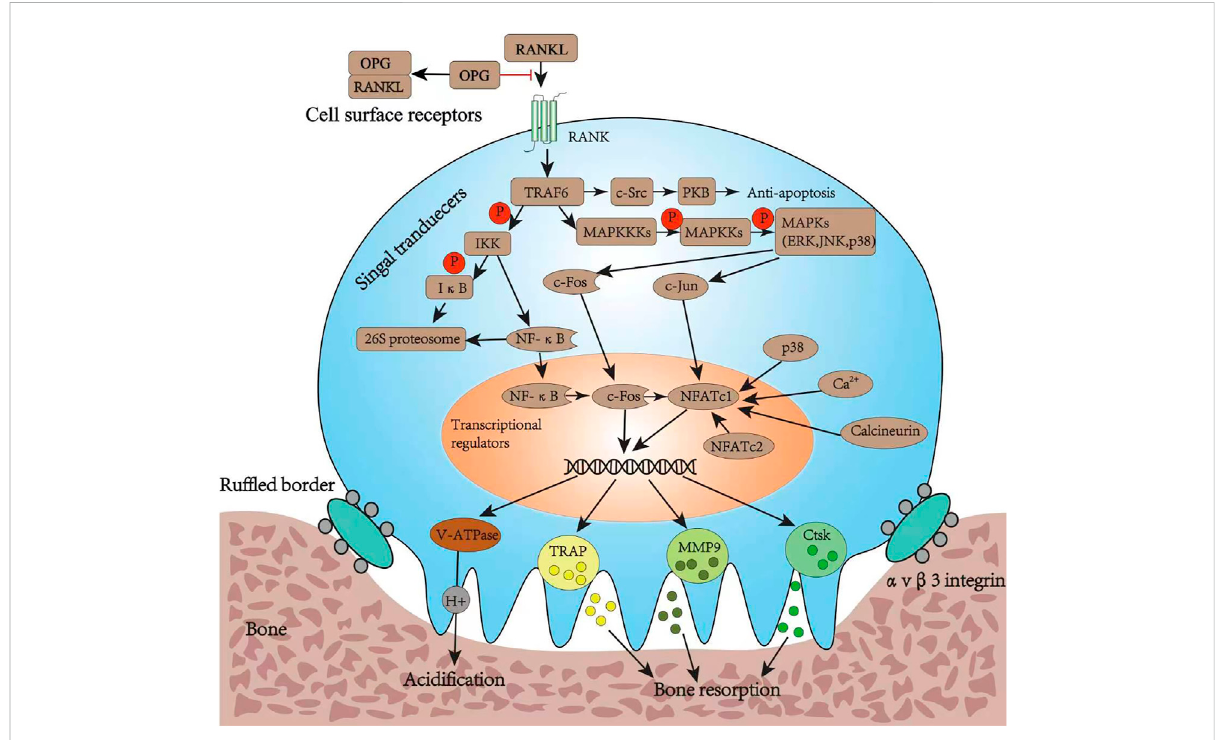
FIGURE 3 Osteoclast differentiation pathways and its bone resorption function. RANKL, ligand of receptor activator of nuclear factor κ B; RANK, receptor activator of nuclear factor κ B; OPG, osteoprotegerin; TRAF6, tumor necrosis factor receptor-associated factor 6; IKK, inhibitor of nuclear factor κ B kinase; I κ B, inhibitor of nuclear factor kappa B; NF- κ B, nuclear factor- κ B; PKB, protein kinase B; MAPKKK, mitogen-activated protein kinase; MAPKK, mitogen-activated protein kinase; MAPK, mitogen-activated protein kinase; ERK, extracellular regulated protein kinase;JNK, c-Jun N-terminal kinase; NFATc1, nuclear factor of activated T cell cytoplasmic 1; NFATc2, nuclear factor of activated T cell cytoplasmic 2; V-ATPase, vacuolar H (+) ATPase; TRAP, tartrate-resistant acid phosphatase; MMP9, matrix metalloproteinase 9; Ctsk, cathepsin